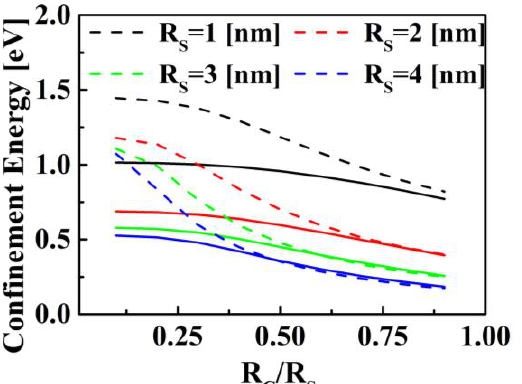
Figure 6. Effect of total QD radius, R S , and core-to-shell radius ratio, R c /R s, on the confinement energy of electron (solid lines) and hole (dashed lines).